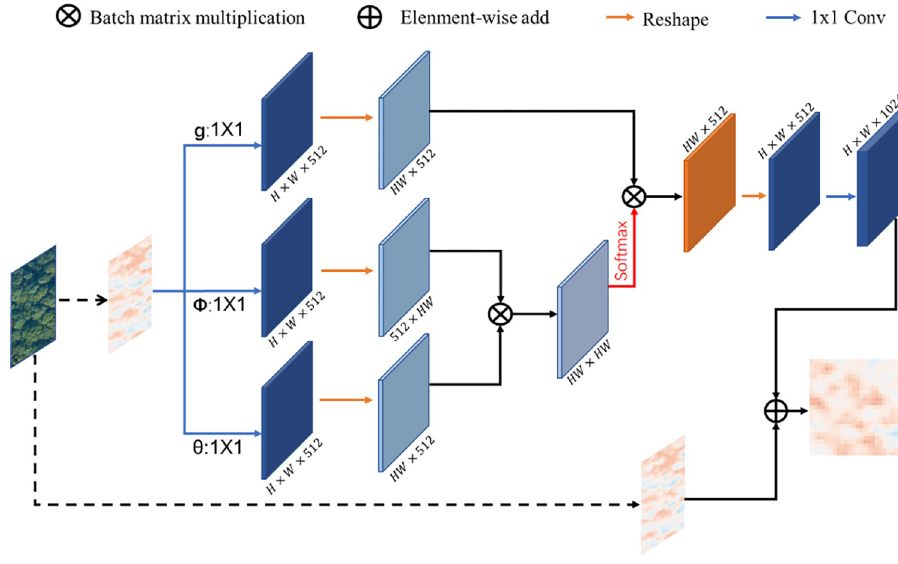
Fig 9. The embedded non-local